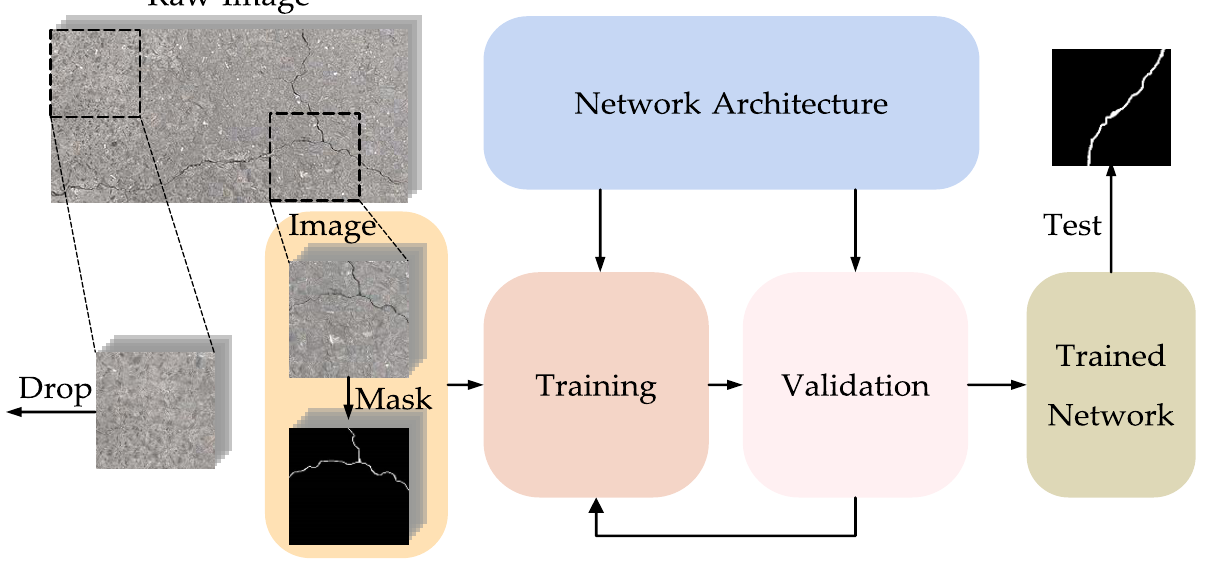
Figure 3. Overview of the proposed segmentation framework.